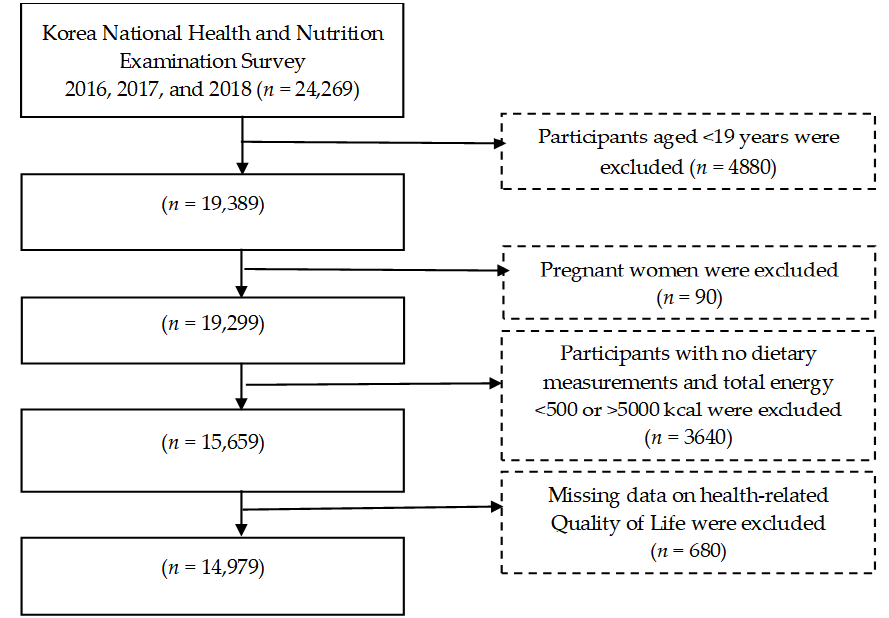
Figure 1. Flow chart of the study participants.